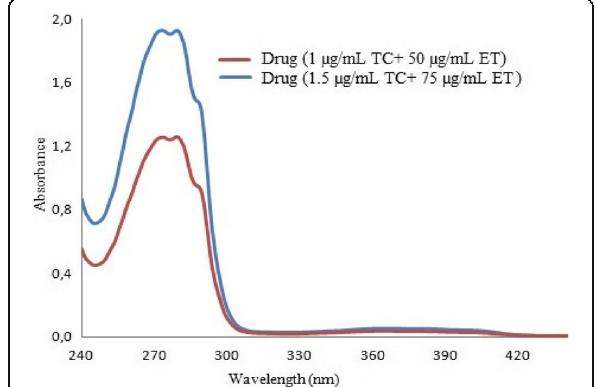
Fig. 4 UV absorption spectra of the drug (Etotio tablets) solutions containing ET (50 μ g/mL and 75 μ g/mL) and TC (1 μ g/mL and 1.5 μ g/mL)